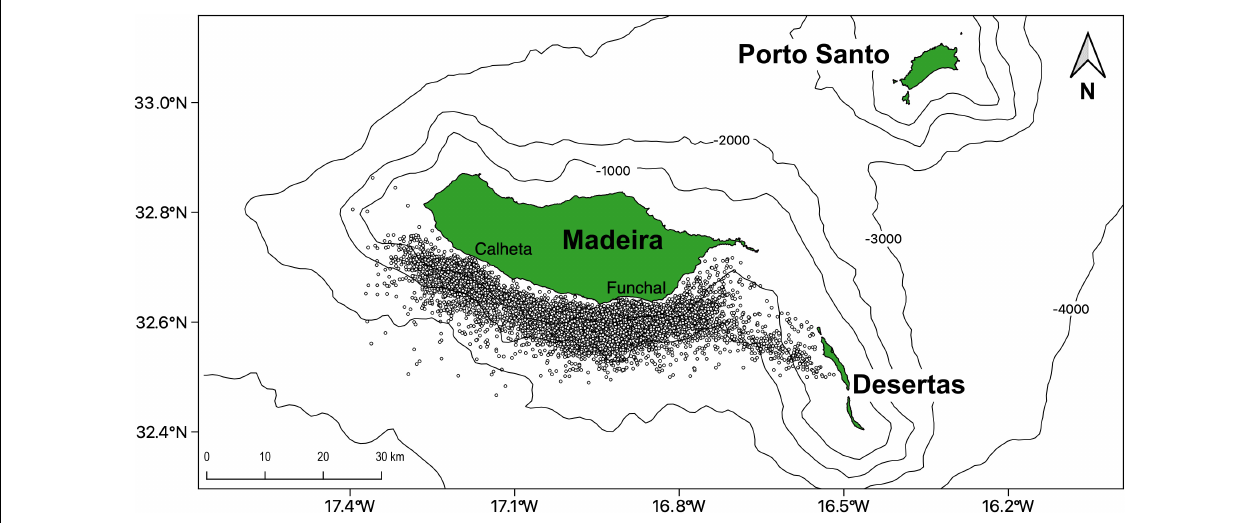
FIGURE 1 | Cetacean sightings for 23 species ( n = 8,607) pooled together, collected by the commercial whale watching companies departing from Funchal and Calheta in Madeira Island (Portugal) from 2003 until 2018.